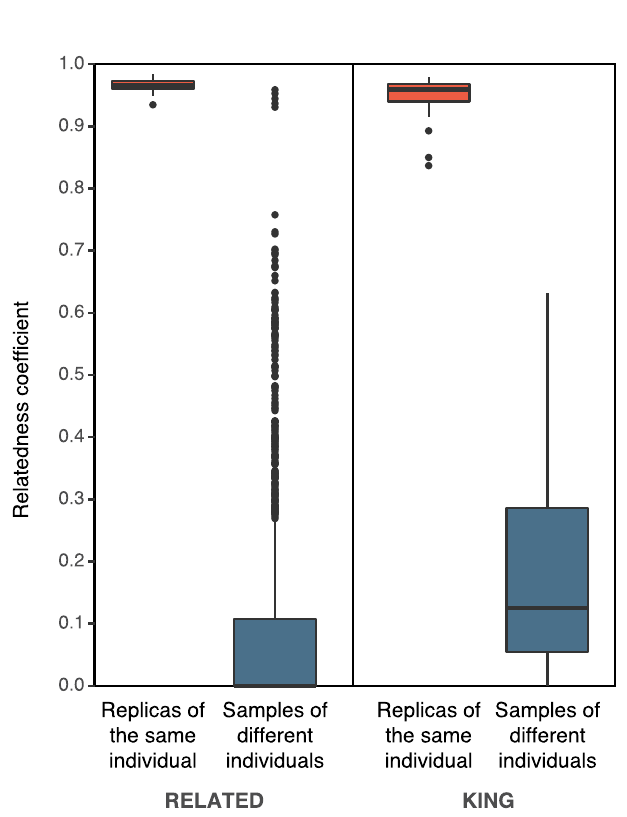
Figure 5. Boxplots of relatedness coefficients obtained using RELATED and KING for the analysis of replicates of the same individual and samples of different